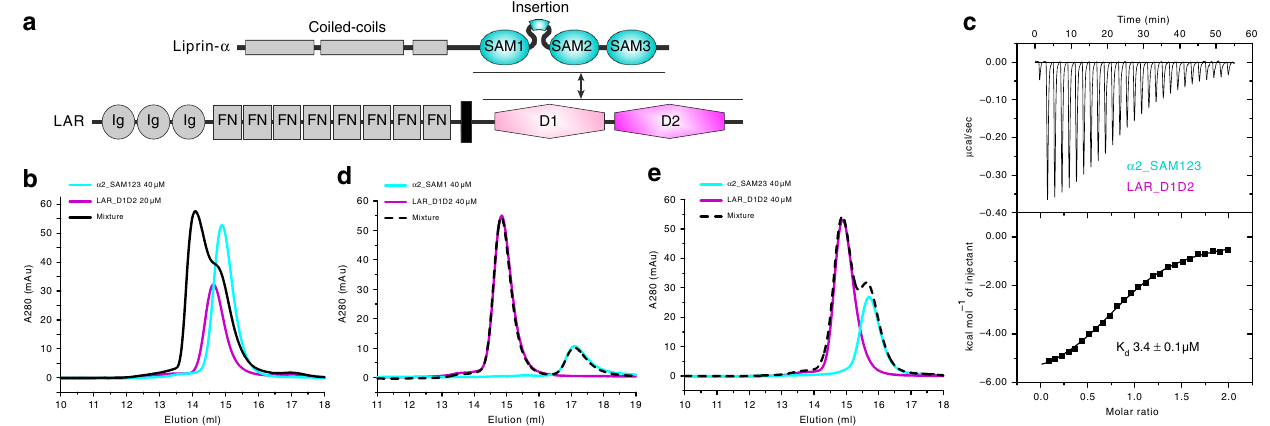
Fig. 1 Biochemical characterization of the liprin- α and LAR-RPTP interaction. a Cartoon diagrams of domain organizations of liprin- α and LAR. The color- coding of the regions is applied throughout the entire manuscript except as otherwise indicated. b , d , e Analytical gel fi ltration analysis showing the interaction with LAR requires all three SAM domains of liprin- α . c Isothermal titration calorimetry (ITC)-based measurement of the binding of α 2_SAM123 to